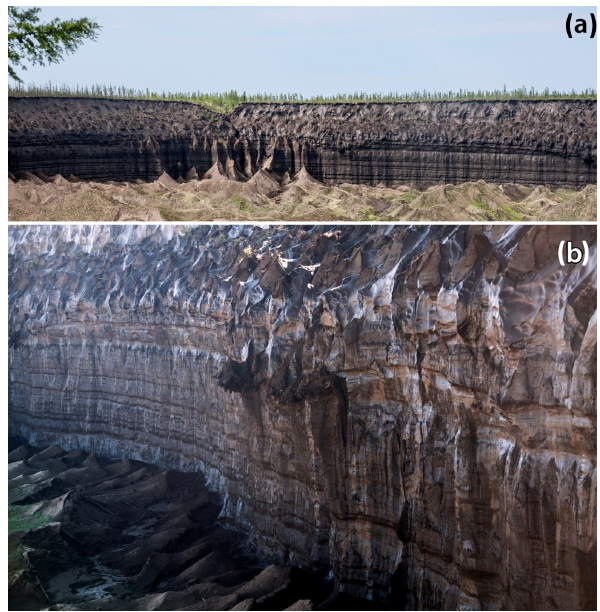
Figure 8. (a) Total view of the southwestern part of the outcrop showing that the sequence continues homogeneously over large dis- tances. In the left central part of the photo, note the section of an erosional channel visible in the bottom-left corner of the satellite picture in Fig. 4a. For scale: the trees on top of the profile are on average about 7m tall. (b) Detail of the profile illustrating stratifi- cation and borders between Units II, III, IV, and V. Also, it is shown that accumulations of organic material in Unit III occur at isolated places but not as a recurring pattern as would be assumed for fills of ice wedge casts penetrating Unit IV. Instead, they might repre- sent ancient depressions such as transects of channels resembling the modern one in Fig.